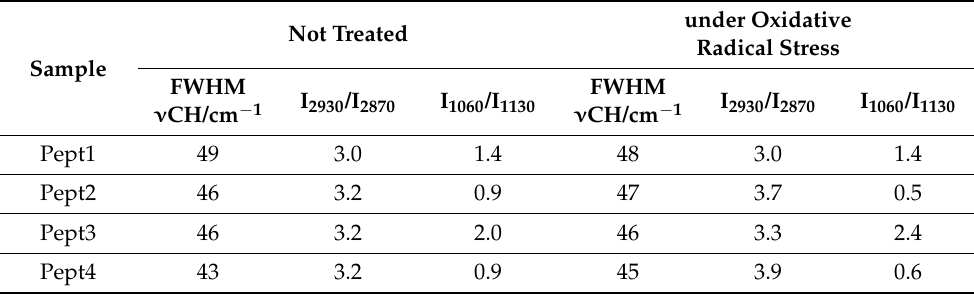
Table 2. Selected parameters of SERS bands involving CH vibrations before and after exposure to free radical stress (obtained by gamma irradiation): Full Width at Half Maximum (FWHM) of the ν CH band, I 2930 /I 2870 and I 1060 /I 1130 intensity ratios indicating the order degree of aliphatic side chains of the oligopeptides [58]. Not Treated Sample